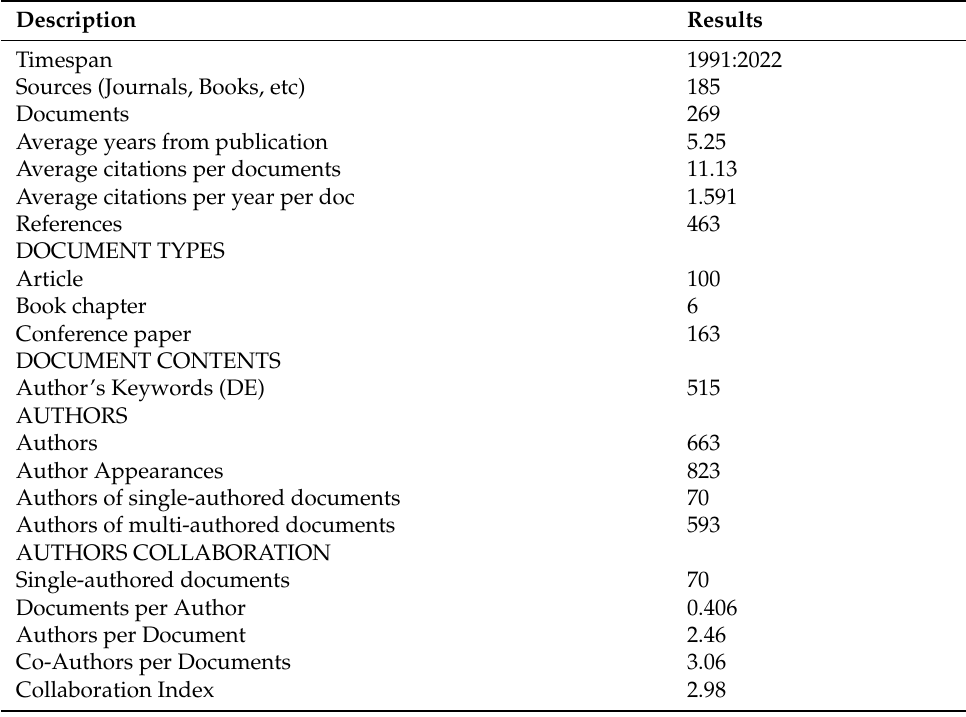
Figure 2. Historical frequency of research. Table 1. Descriptive statistics of the reviewed